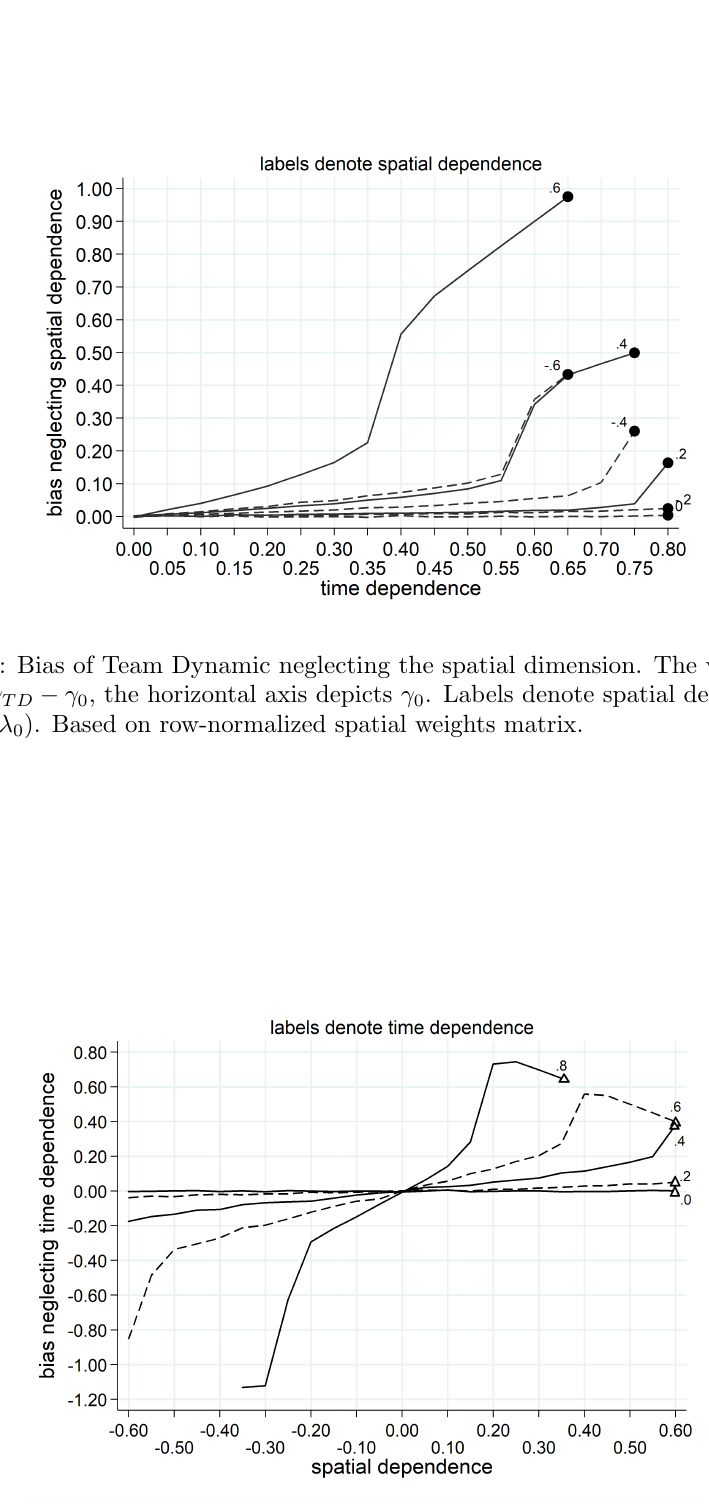
Figure E.6: Bias of Team Spatial neglecting the time dimension. The vertical axis describes λ TS − λ 0 , the horizontal axis depicts λ 0 . Labels denote spatial dependence in the DGP ( γ 0 ). Based on row-normalized spatial weights